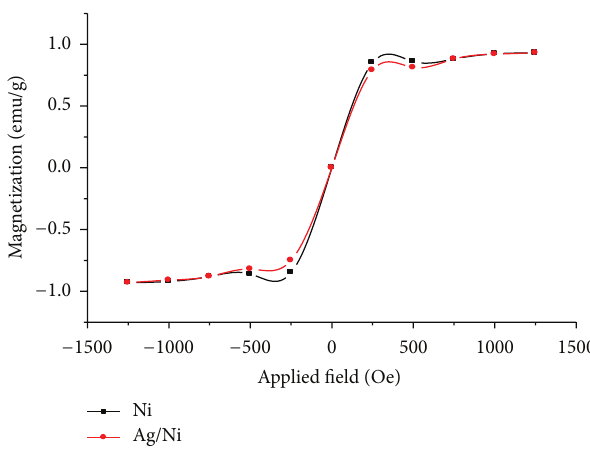
Figure 8: Hysteresis curve of Ni and Ni/Ag